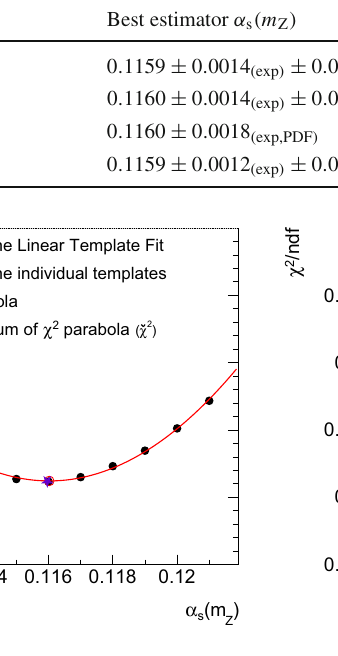
Fig. 9 Illustration of χ 2 / n dof values in the fit of NLO pQCD predic- tions to CMS inclusive jet cross section data. Shown are the χ 2 / n dof value of the Linear Template Fit at its best estimator (star), the χ 2 / n dof values of the individual templates (full circle), and the calculated χ 2 parabola(seeSect.10.3)anditsminimum(opencircle).Left: χ 2 / n